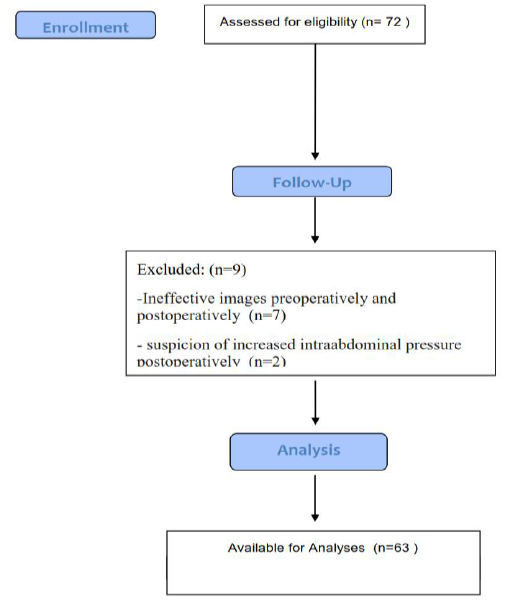
Figure 1. Flow chart.